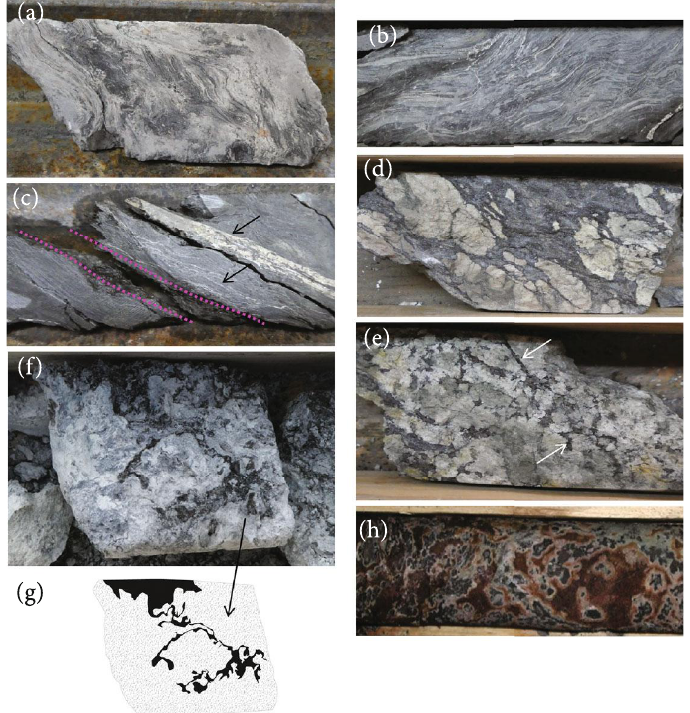
Figure 20: Deformation patterns and textures observed in mineralized dilation jog zones. (a, b) Reopened foliation with disseminated mineralization in a graphite-rich shear zone (HK18-82@263.9m, 3800cps; HK17-80@261.2m, 5500cps, respectively). Reopened foliation is underlined by pale grey clay (a) and white clay-carbonate (b) sealed veins. (c) Mineralized vein (pink) with parallel white clay-carbonate and quartz veins (arrows) reopening foliation (HK17-79@278.3m, > 10.000cps). (d) Well-developed cataclastic corrosion/dissolution breccia (HK15-33@358m). (e) Protocataclastic-corrosion/dissolution breccia still showing the initial microfractures from which fl uids leaked into the host rock (HK15-33@357 m). (f) Protocataclastic corrosion/dissolution breccia from Midwest deposit (MW-855A, 500cps). (g) Sketch of (f) showing the corrosion/dissolution pattern. (h) « Wormy » texture with mineralization from McClean Project (Caribou). Precise location unavailable (see [57]). Scale: diameter of the drill core of all pictures is